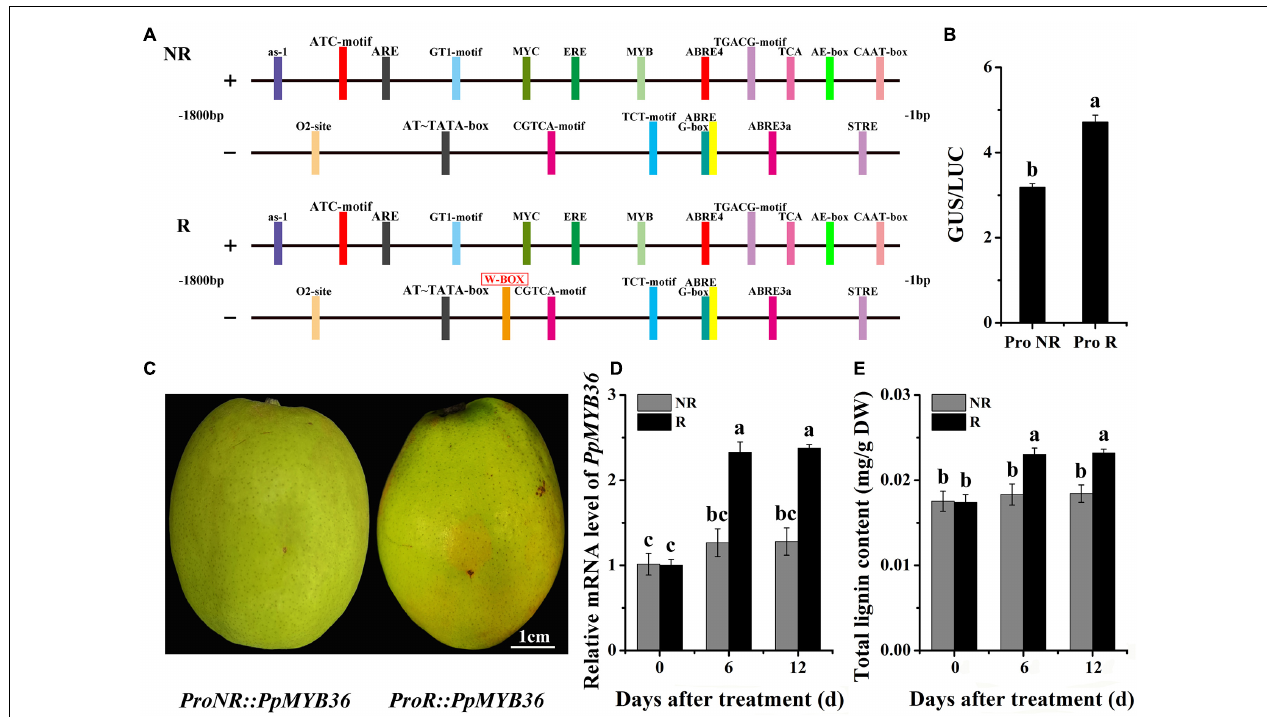
FIGURE 7 | Functional analysis of the PpMYB36 promoter region. (A) Diagrammatic representation of cis-elements present in the PpMYB36 promoter (not drawn to scale). NR: non-russet skin fruits; R: russet skin fruits. (B) Relative GUS/LUC activity in infiltrated callus. ProNR : PpMYB36 promoter from non-russet skin pear; ProR : PpMYB36 promoter from russet skin pear. (C) Phenotypes of pear skins infiltrated with agrobacterium harboring ProNR:PpMYB36 and ProR:PpMYB36 . (D) Relative expression levels of PpMYB36 in the skins of infiltrated fruits 0 to 12 days after agroinfiltration. (E) Concentration of lignin in the skins of infiltrated fruits 0 to 12 days after agroinfiltration. Different lowercase letters above bars mean significant differences between NR and R groups by Tukey’s multiple range tests ( p <